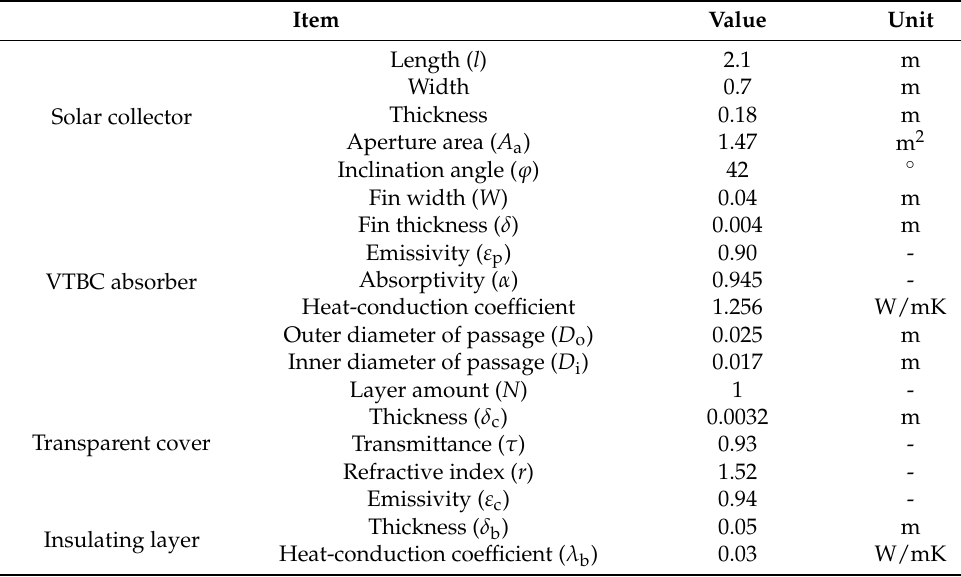
Table 2. Input parameters of the reference collector